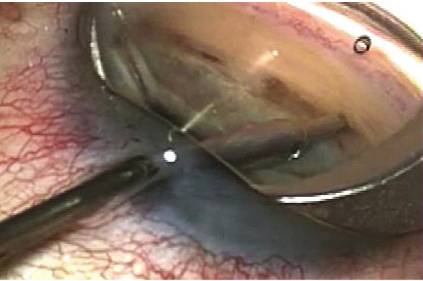
Figure 1: Ab interno trabeculotomy with the Trabectome device.